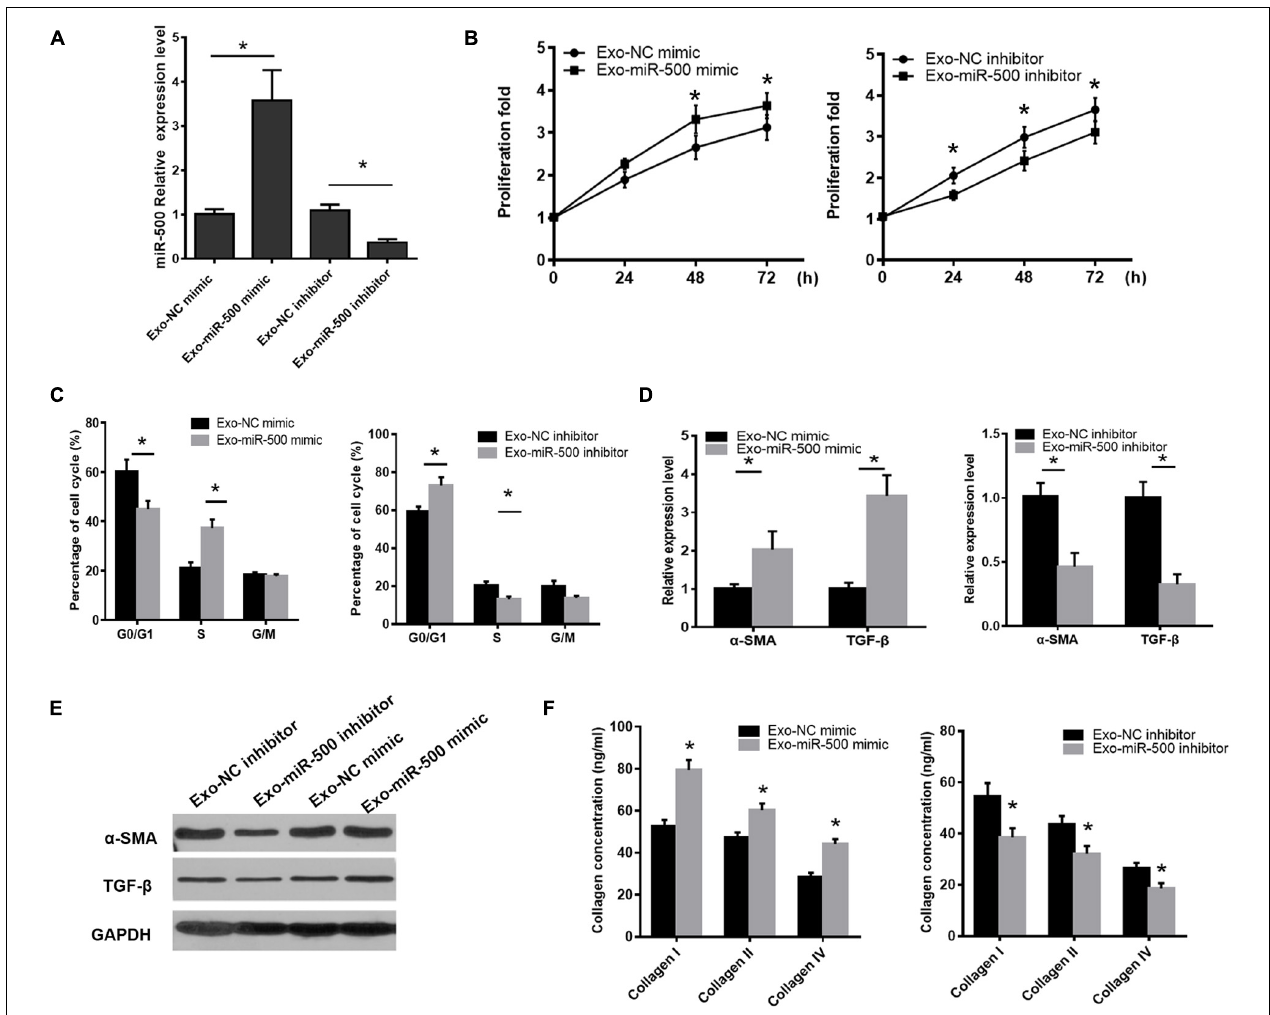
FIGURE 2 | Exosomal miR-500 affects HSC proliferation and activation. (A) The expression levels of miR-500 in exosomes derived from macrophages transfected with miR-500 mimic or inhibitor and relative controls. (B) HSCs were treated with exosomes with miR-500 overexpression or inhibition, and then cell proliferation was determined by CCK-8 assays. (C) HSCs were treated with exosomes with miR-500 overexpression or inhibition, and the cell cycle was detected by using Flow cytometry. (D) HSCs were treated with exosomes with miR-500 overexpression or inhibition, and then the expression levels of α -SMA and TGF- β were detected by using qRT-PCR. (E) HSCs were treated with exosomes with miR-500 overexpression or inhibition, and then the expression levels of α -SMA and TGF- β were detected by using western blot. (F) HSCs were treated with exosomes with miR-500 overexpression or inhibition, and then the concentrations of type I, III, and IV collagen in the cell culture supernatant were tested by ELISA. The results are shown as mean ± SD of three independent experiments. * P <